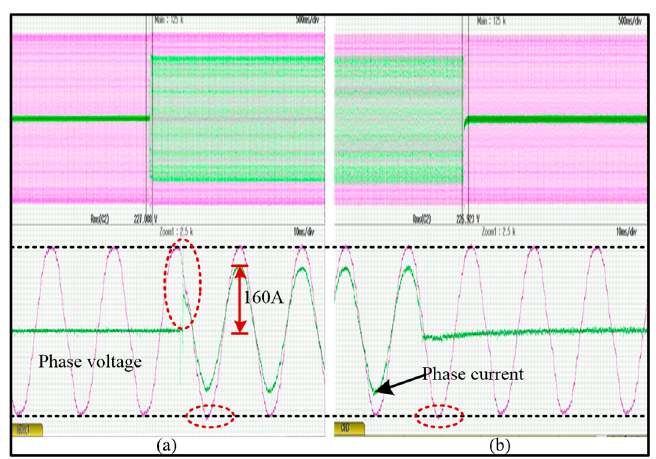
Figure 15. Voltage and current waveforms with instantaneous load. ( a ) Load input experiment; ( b ) Load removal experiment.